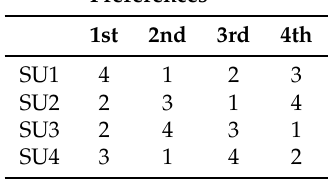
Table 5. Channel’s preference list.